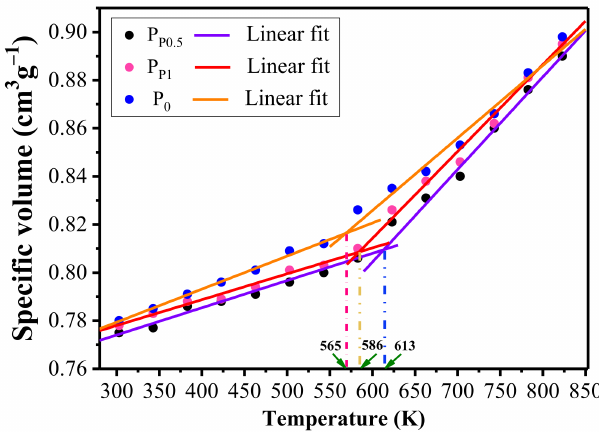
Figure 7. Glass transition temperature for the three models.